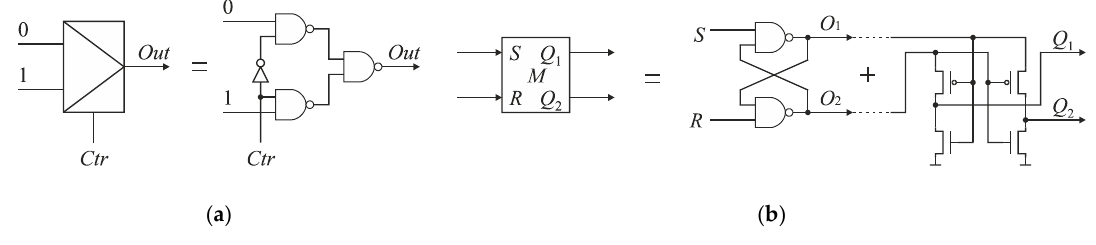
Figure 21. Diagram of: ( a ) two-to-one multiplexer; ( b ) MUTEX block.